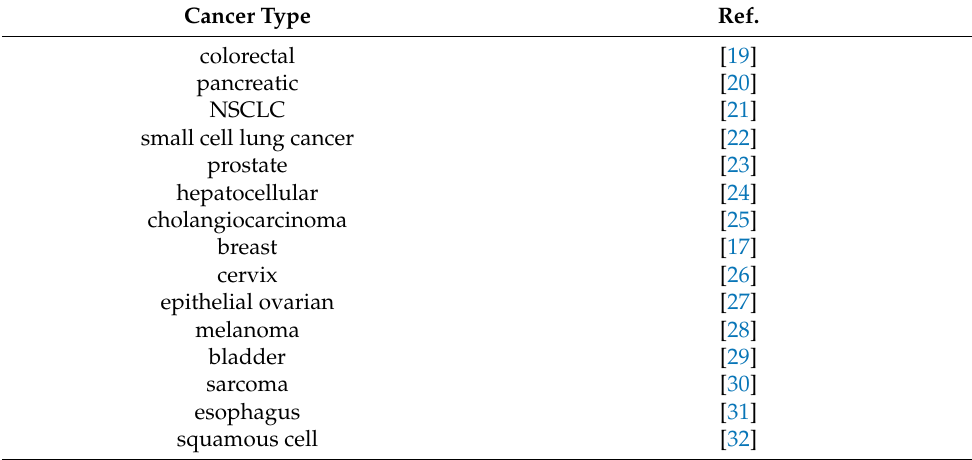
Table 1. List of selected, recent, peer reviewed, published meta-studies of research indicating that a higher neutrophil-to-lymphocyte ratio (NLR) is associated with a shorter overall survival in several common